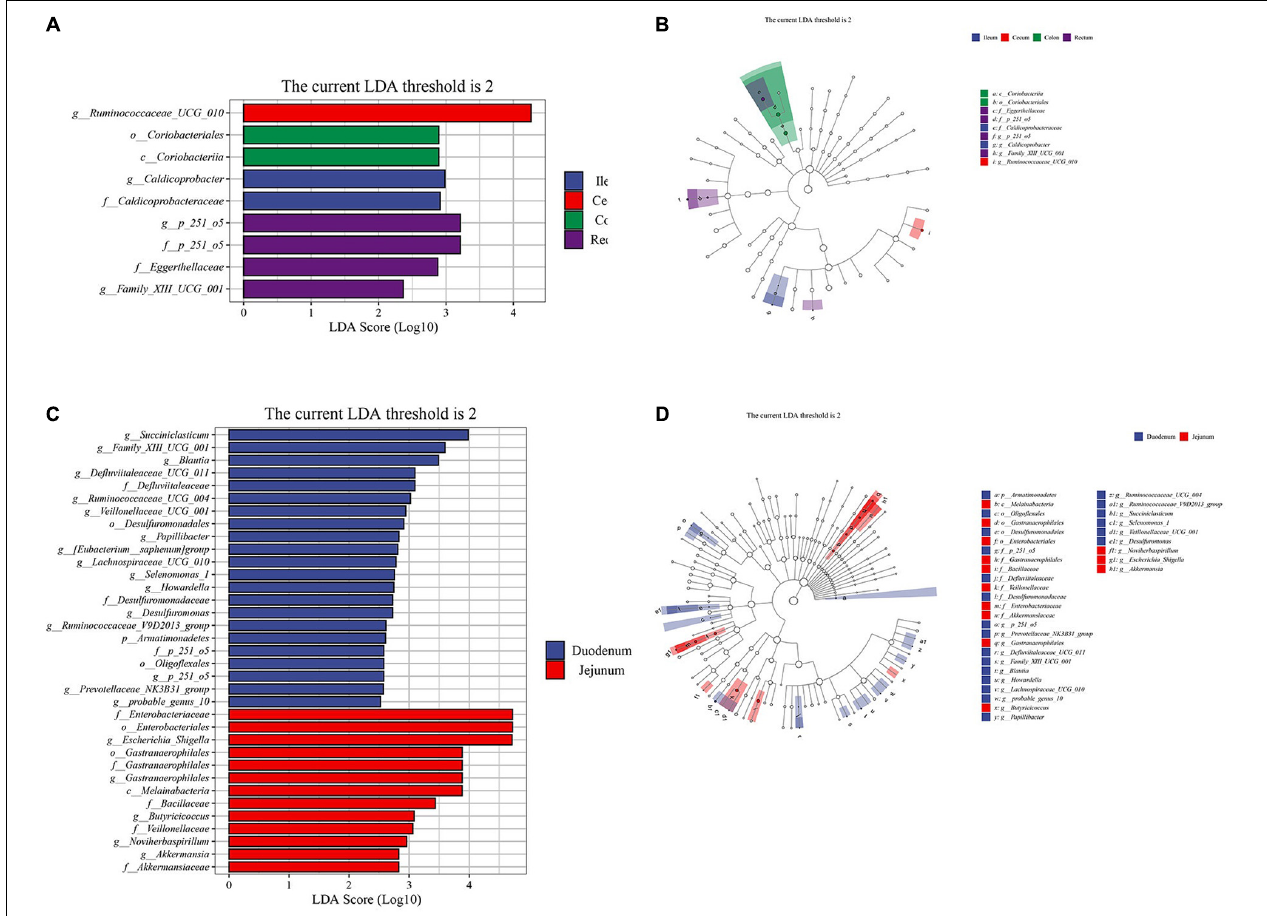
FIGURE 4 | Linear discriminant analysis (LDA) effect size (LEfSe) analysis of the intestinal segments of Aohan fine-wool sheep. The LEfSe analysis histogram of hindgut (A,C) foregut. The ordinate is the taxa with significant differences between groups, and the abscissa is a bar graph displaying the LDA logarithmic score value of each taxon. The longer the length, the more significant the difference of the taxon, and the color of the bar graph indicates the sample group with the highest abundance corresponding to the taxon. The LEfSe analysis branch diagram of hindgut (B,D) foregut. The node size corresponds to the average relative abundance of the taxa, and the hollow nodes represent taxa with insignificant differences between groups. The letters identify the names of taxa that differ significantly between the